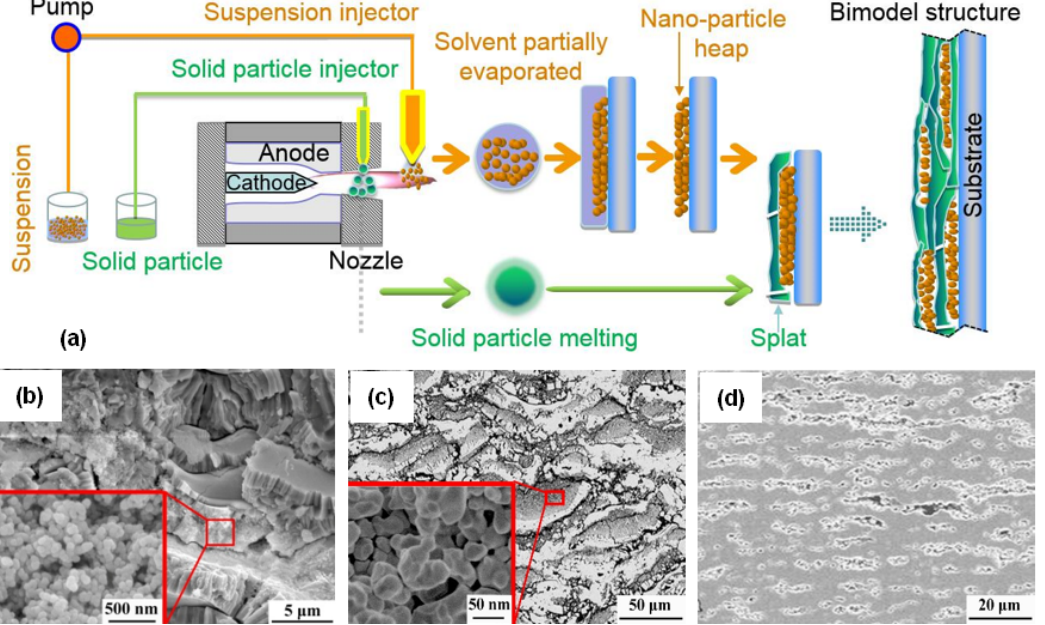
Fig. 63 Preparation process and microstructures of the bimodal coatings: (a) schematic demonstration of the plasma co-spraying with suspension and solid powder. (b–d) Morphologies of micro-lamellae/nano-zone bimodal coatings. Reproduced with permission from Ref. [13] for (a, b), © ASM International 2018; Ref. [379] for (c), © ASM International 2008; and Ref. [375] for (d), © ASM International